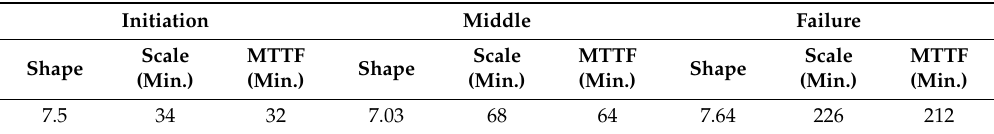
Table 4. Shape and scale parameter of tree model 2.